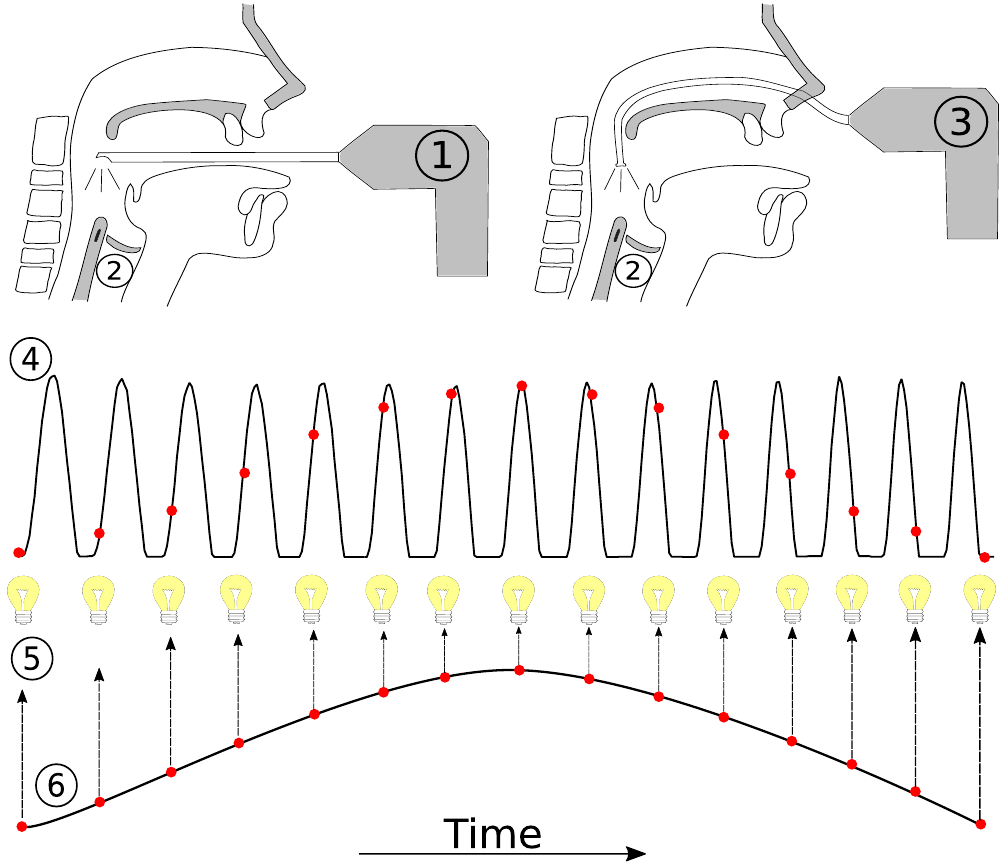
Figure 2. Illustration of the stroboscopic sampling. Adapted from [27]. (1) and (3) are the rigid and flexible endoscope, respectively; (2) are the vocal folds; (4) represents the real vibratory pattern; (5) illustrates the strobe light; (6) is the estimated version of the vibratory